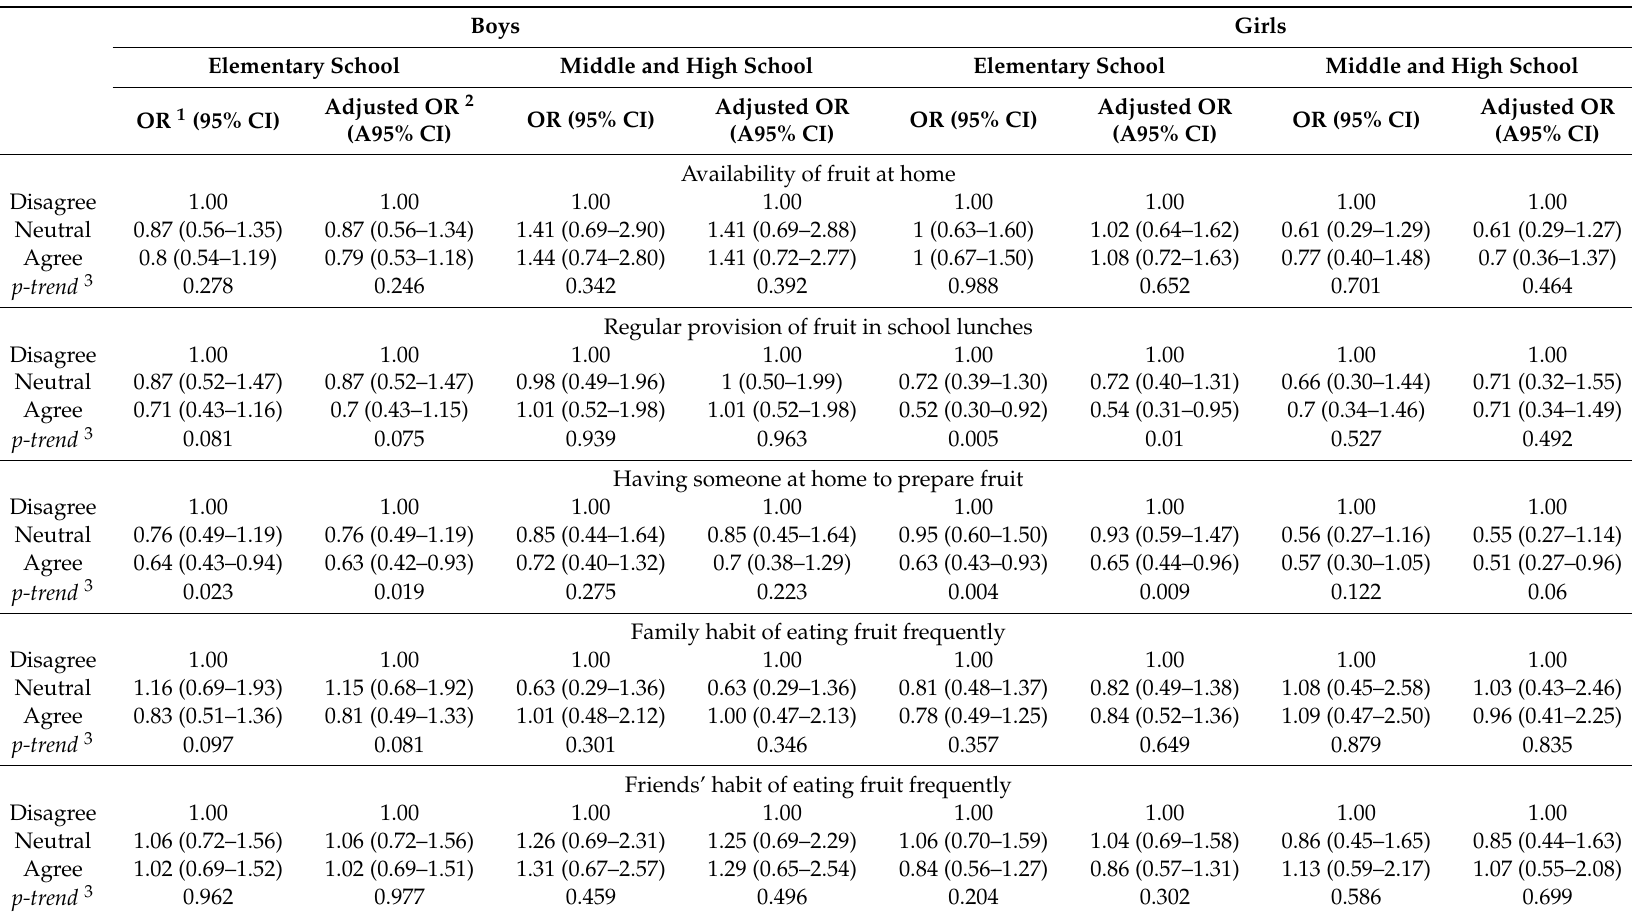
Table 5. Relationship between aspects of participants’ food environments and odds of being